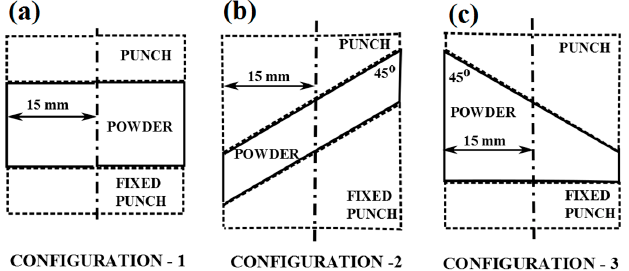
Figure 4. Adopted configurations for calibration through powder compaction tests: a flat cylinder ( a ), an inclined cylinder ( b ) and a combination of the two ( c ).